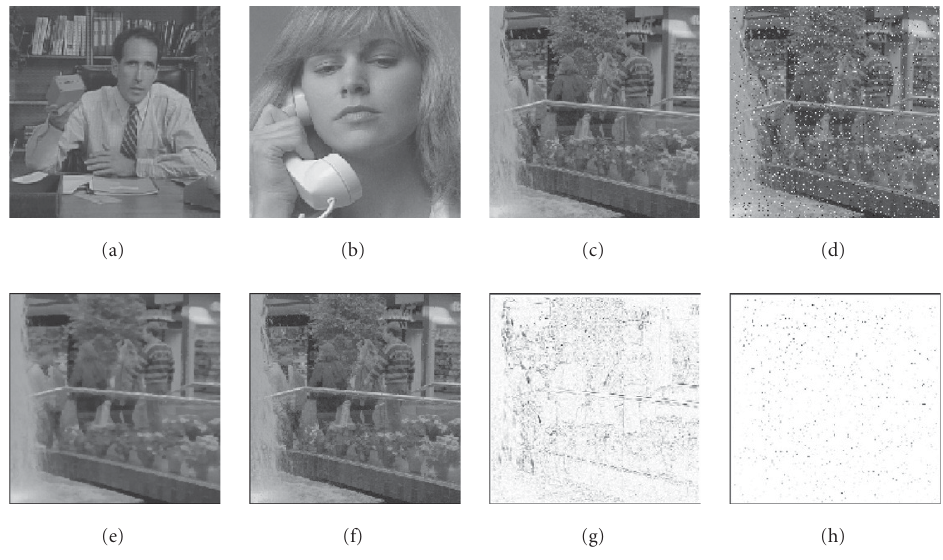
Figure 2: The 5th frame of the test videos: (a) Salesman, (b) Woman, (c) People, (d) image contaminated with 10% impulsive noise, (e) MF output, (f) reduced NAVF output, (g) MF estimation error emphasized by a factor of 3, and (h) reduced NAVF estimation error emphasized by a factor of 3. Table 1: Comparison of the presented algorithms using test videos corrupted with 5% impulsive noise. Test video Salesman Woman